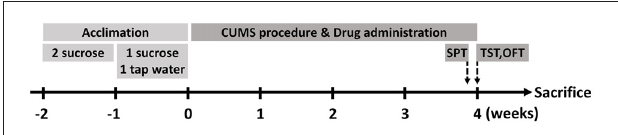
FIGURE 1 | Schematic diagram of the research. Mice were allowed to acclimate for two consecutive weeks before stress protocol. After acclimation, they were divided into three groups ( n = 10 for each group). At the end of chronic unpredictable mild stress (CUMS) procedure, behavioral tests were performed and then the animals were executed in the next